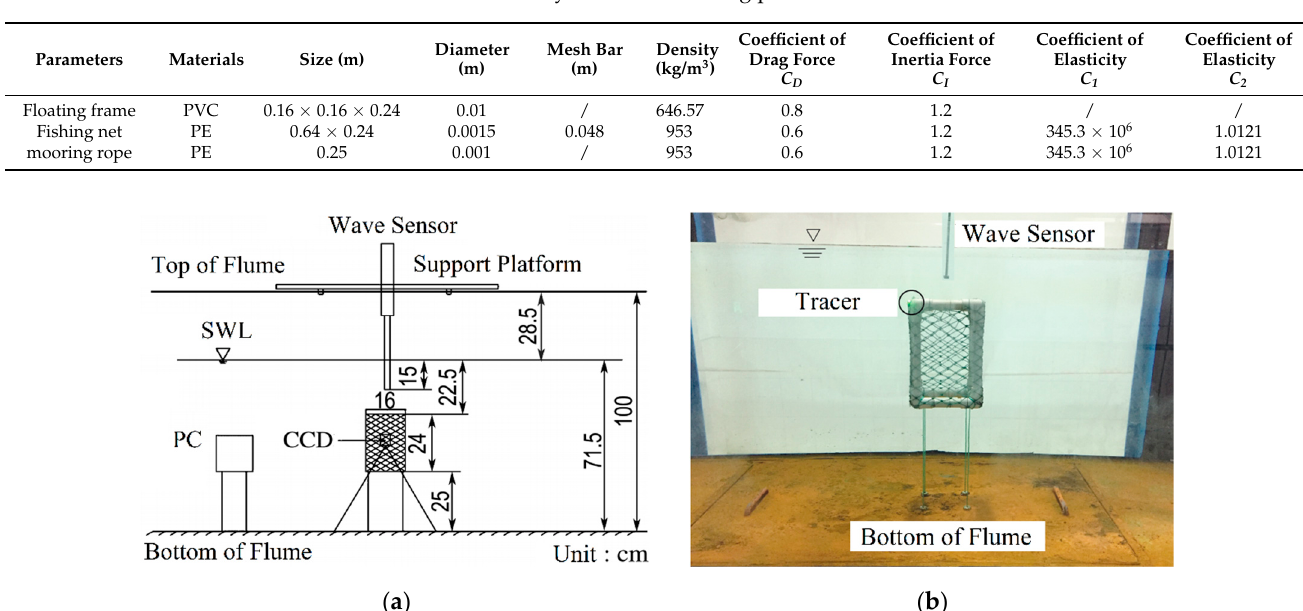
Table 2. Physical model setting parameters.